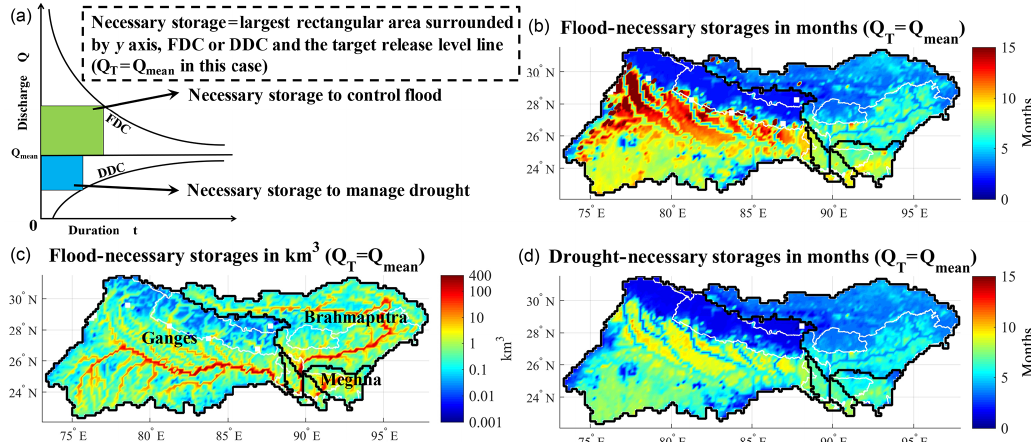
Figure 10. In nature, changes in the storage of water in a hydrological basin can smooth out hydrological variations associated with floods and droughts. The spatial variability in necessary hydrological storage, however, remains relatively unstudied – at the present time there is no global map showing the storage needed to ameliorate floods and droughts, either for the present climate or under climate change. Using the Ganges–Brahmaputra–Meghna Basin as an example, the needed storage at each grid cell within the basin is calculated with a new method: intensity–duration–frequency curves of flood and drought (flood duration curve and drought duration curve: FDC-DDC, an alternative rep- resentation of discharge time series obtained from a calibrated hydrological model called BTOPMC – see Takeuchi and Masood, 2016). For simplicity, the target release ( Q T ) for smoothing is assumed to be the long-term mean discharge ( Q mean ) at each grid cell (Takeuchi and Masood, 2016). The figure shows a typical FDC-DDC curve for a grid cell and an illustration of how to calculate necessary storage (a) , the spatial distribution of storage (in units of km 3 ) needed to smooth floods in the basin (c) , and the spatial distribution of storage (in units of months) needed to smooth flood (b) and drought (d) . Note that storages expressed in months, calculated by dividing the necessary storage volume by the local Q mean for 1979–2003, provide a unique perspective on storage requirements. The geographical distribution of necessary storage reflects hydrological heterogeneity associated with meteorological inputs, topography, geology, soil, vegetation, land use, and so on. Quantifying the relationships between spatially distributed necessary storages and the geographical distribution of hydroclimatological, geo- logical, and land cover conditions can lead to improved hydrological analysis and produce useful information for water resources managers. (Contact: Muhammad